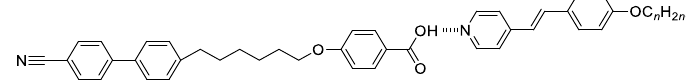
Figure 1. Structure of the CB6OBA:nOS hydrogen-bonded supramolecular dimers.